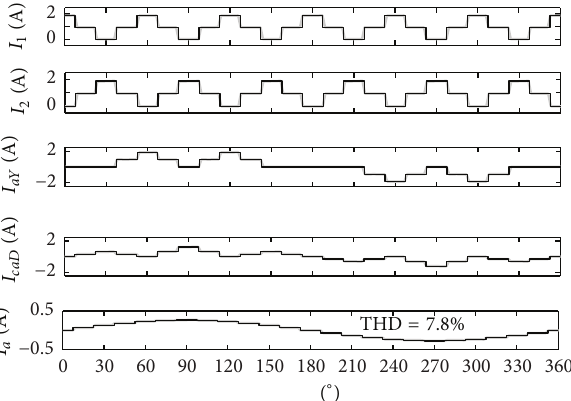
Figure 9: Simulated AC current waveforms for 3-level thyristor based MLCR CSC for 𝛼 = − 45 ∘ without RCD snubber.